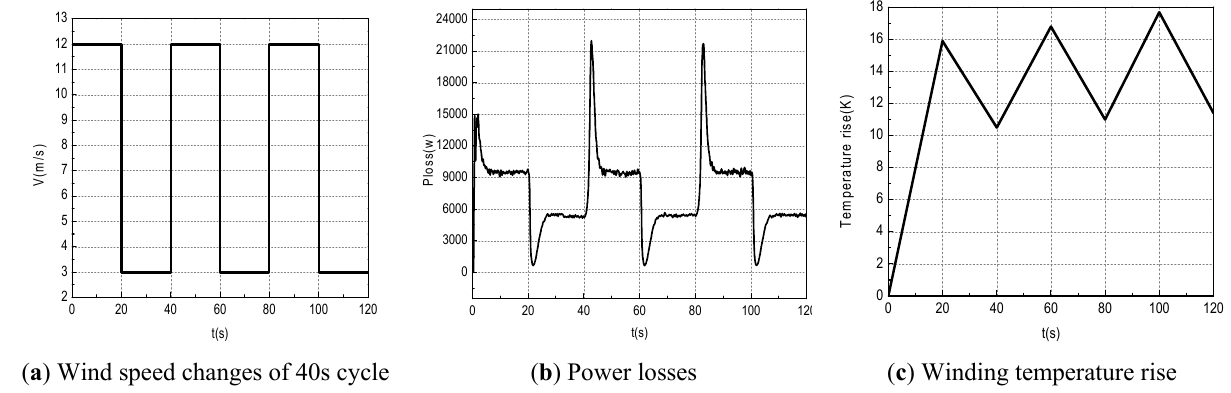
Figure 11. Power losses and temperature rise of stator windings a for wind speed change with a 40 s